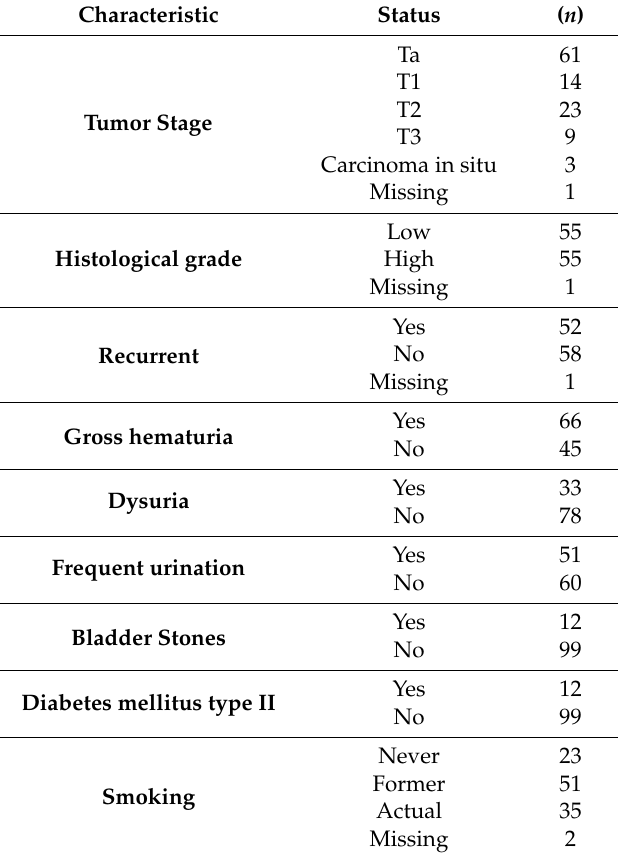
Table 2. Characteristics of the tumor group.